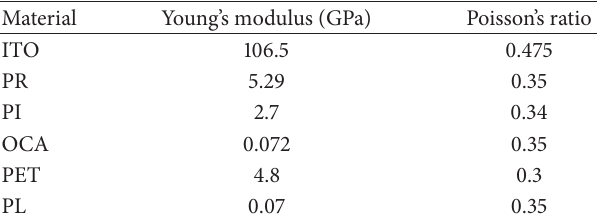
Figure 7: Compressive stress-strain curve of the OCA adhesive. Table 1: Elastic properties of the components in the TDP